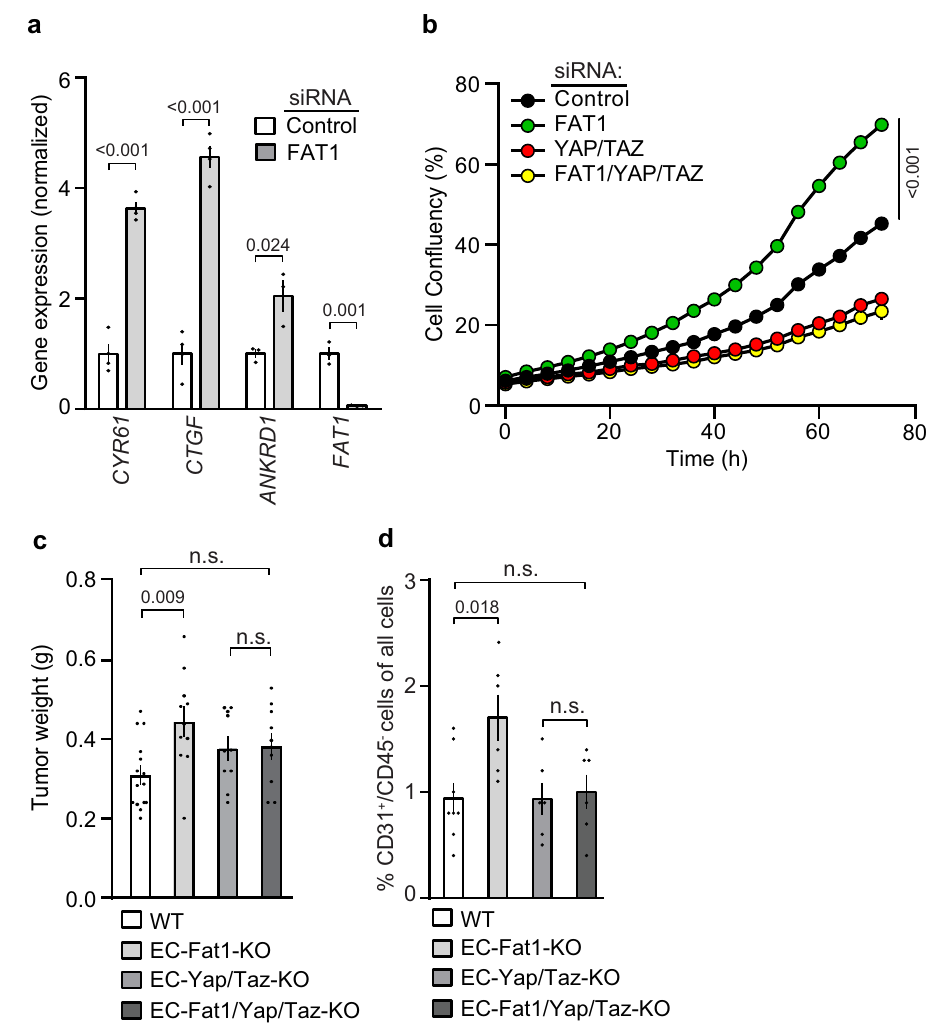
Fig. 4 | YAP/TAZ mediate increased endothelial proliferation in the absence of FAT1 in vitro and in vivo. a Expression of YAP/TAZ target genes in HUVECs after transfection with control siRNA or siRNA directed against FAT1 ( n =3 ( ANKRD1 , FAT1 ) and n =4 ( CYR61 , CTGF )) independent experiments; all data normalized to GAPDHandcontrolsweresetas1. b GrowthcurveofHUVECsaftersiRNA-mediated knock-down of FAT1, YAP/TAZ or FAT1/YAP/TAZ. Cell growth was determined using a live-cell imaging system asdescribed inthe “ Methods ” section. The time of transfection wasset as “ 0 ” ( n =4 independent experiments per group). c , d Tumor